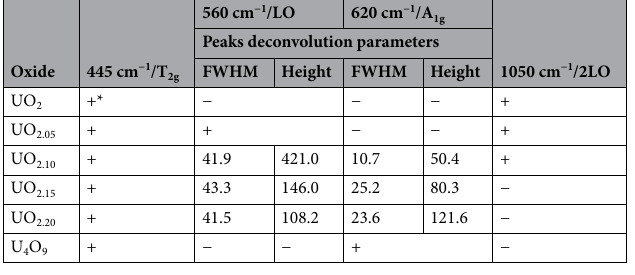
Table 2. Uranium oxides Raman shift peaks